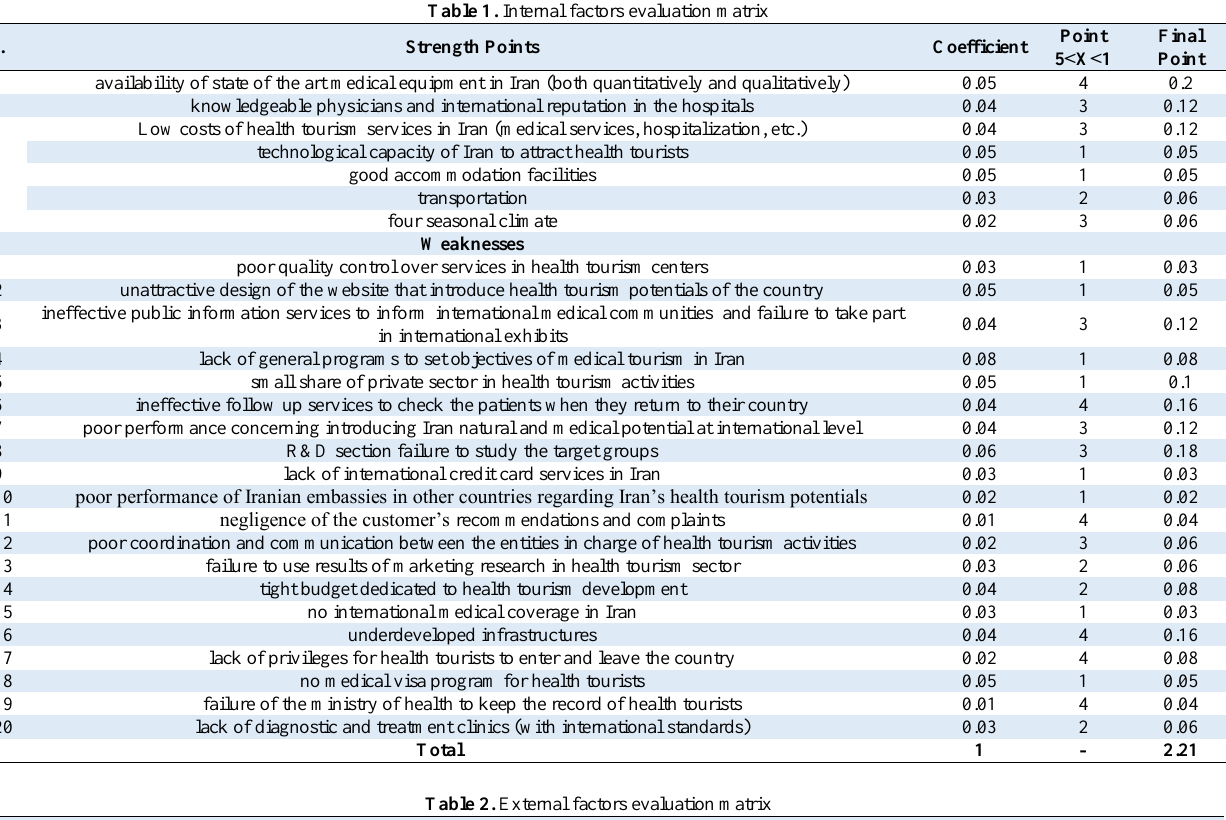
Table 1. Internal factors evaluation matrix